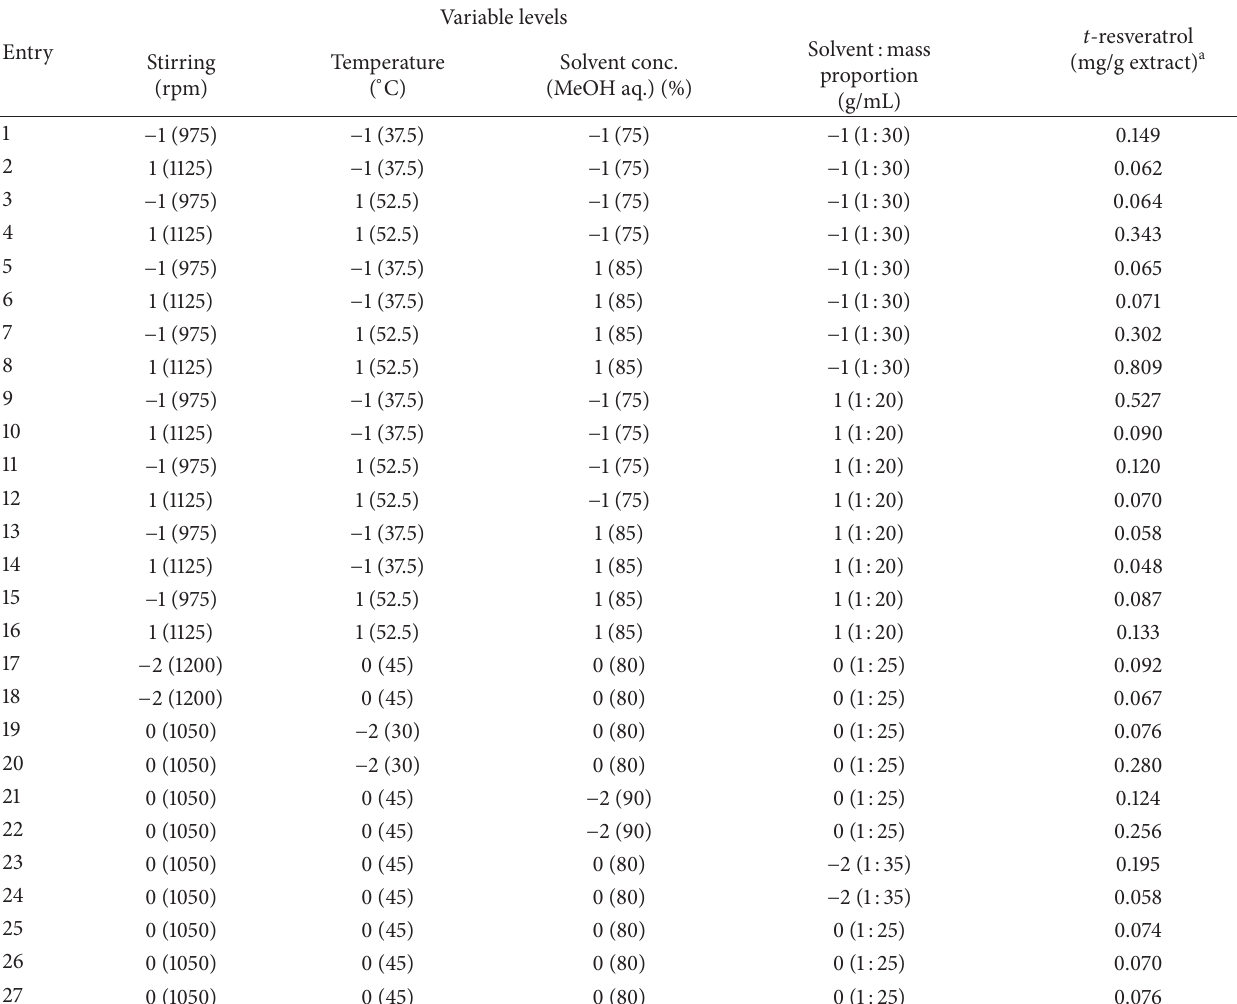
Table 3: Real and coded values (+ level, 0 intermediate, − lower level) for the independent variables, 2 4 – 1 experimental factorial design and results of CCRD for resveratrol extraction by the microwave-assisted